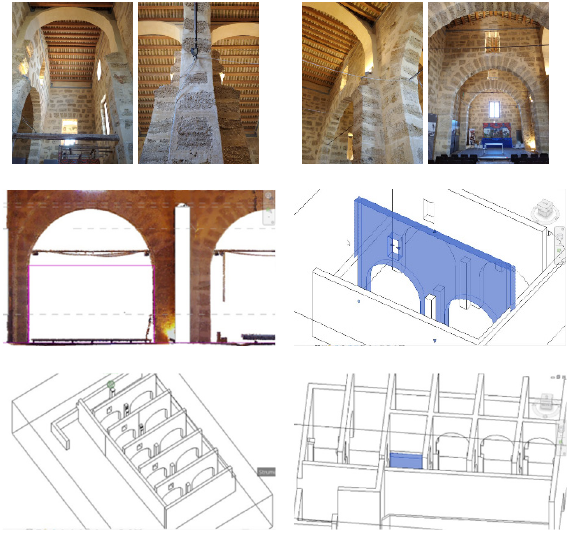
Figure 11 . Parametric modeling of the large arches.